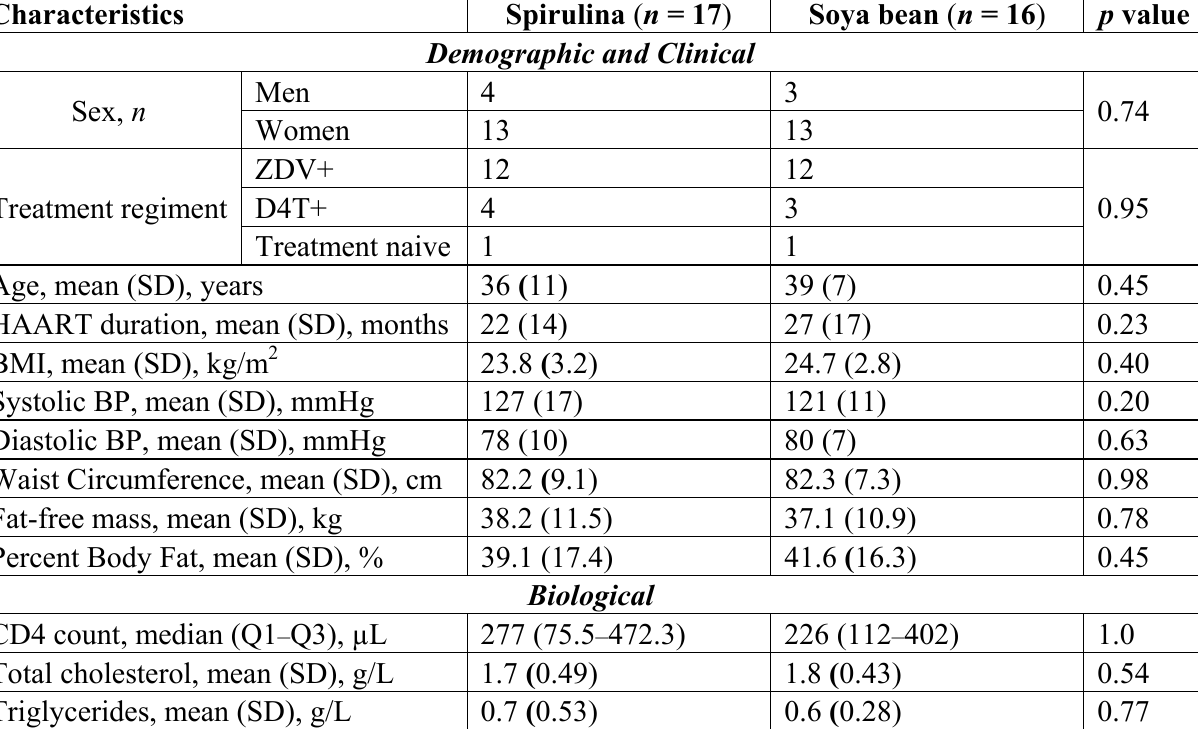
Table 2. Baseline characteristics of